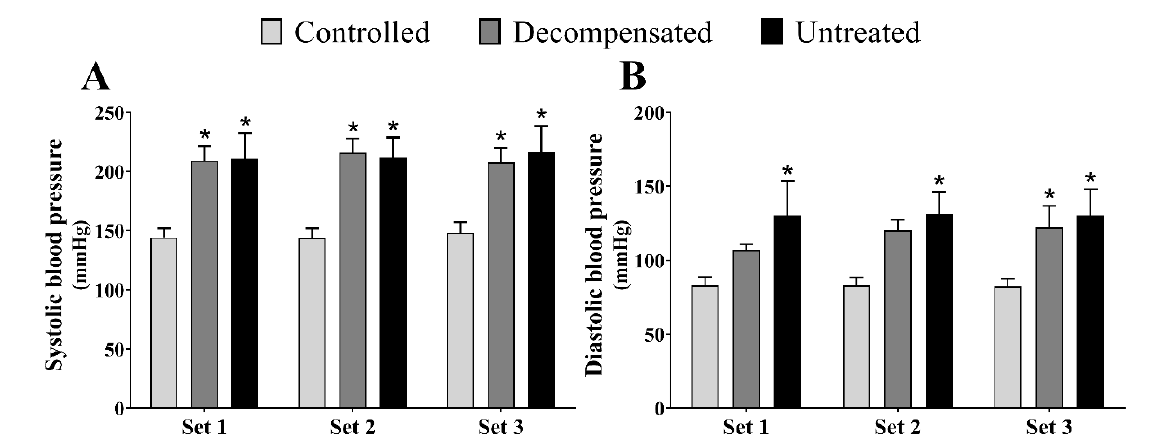
Figure 3 - Peak blood pressure responses during a session of resistance exercise. *p<0.05 vs controlled. ANOVA two-way followed by Tukey